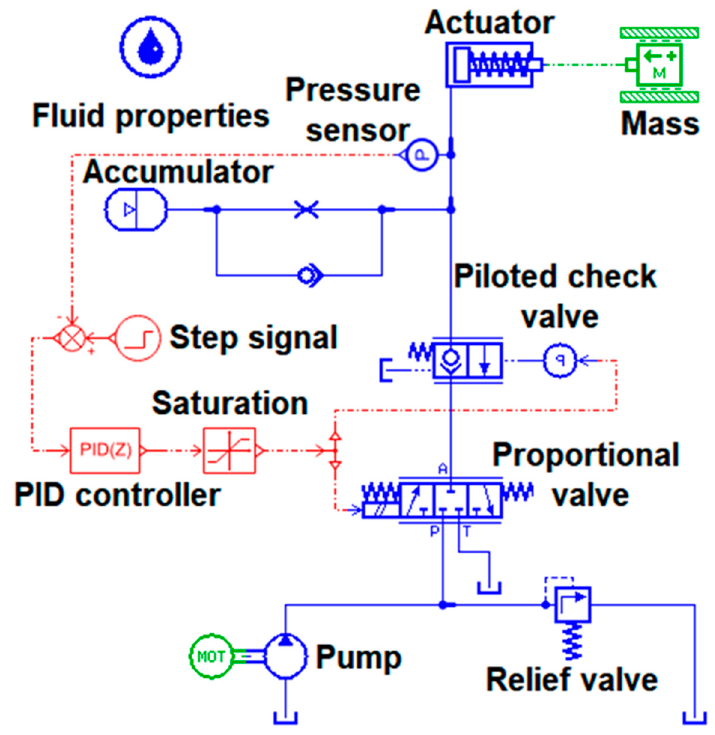
Figure 2. Hydraulic circuit and PID (proportional-integral-derivative) control algorithm of the planting depth control system of a rice transplanter.